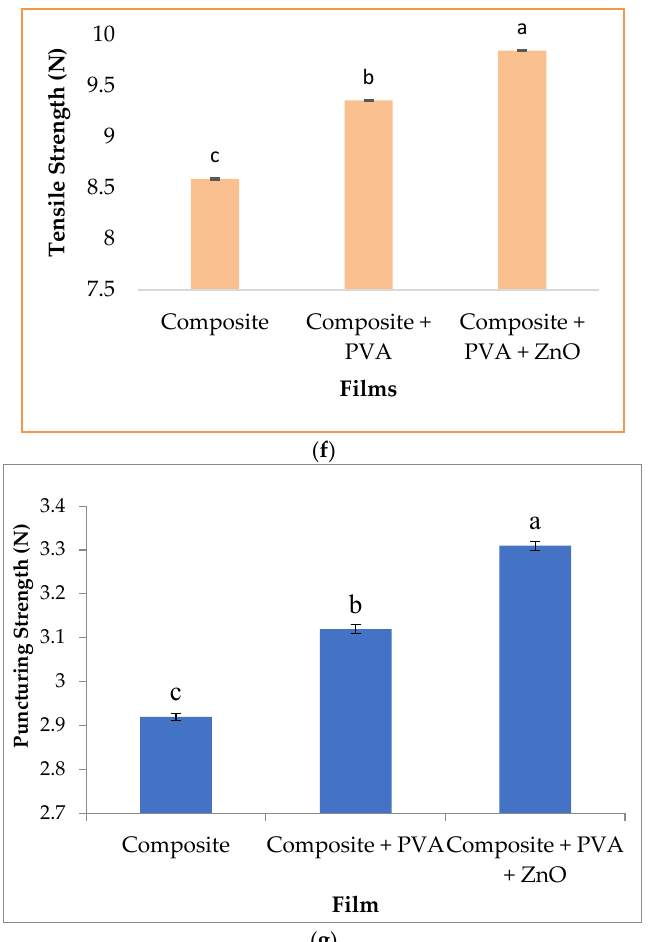
Figure 3. ( a–g ). Properties of different types of films. Means with different superscripts a – c differ Figure 3. ( a – g ) Properties of different types of films. Means with different superscripts a–c differ significantly ( p < 0.05). significantly ( p <